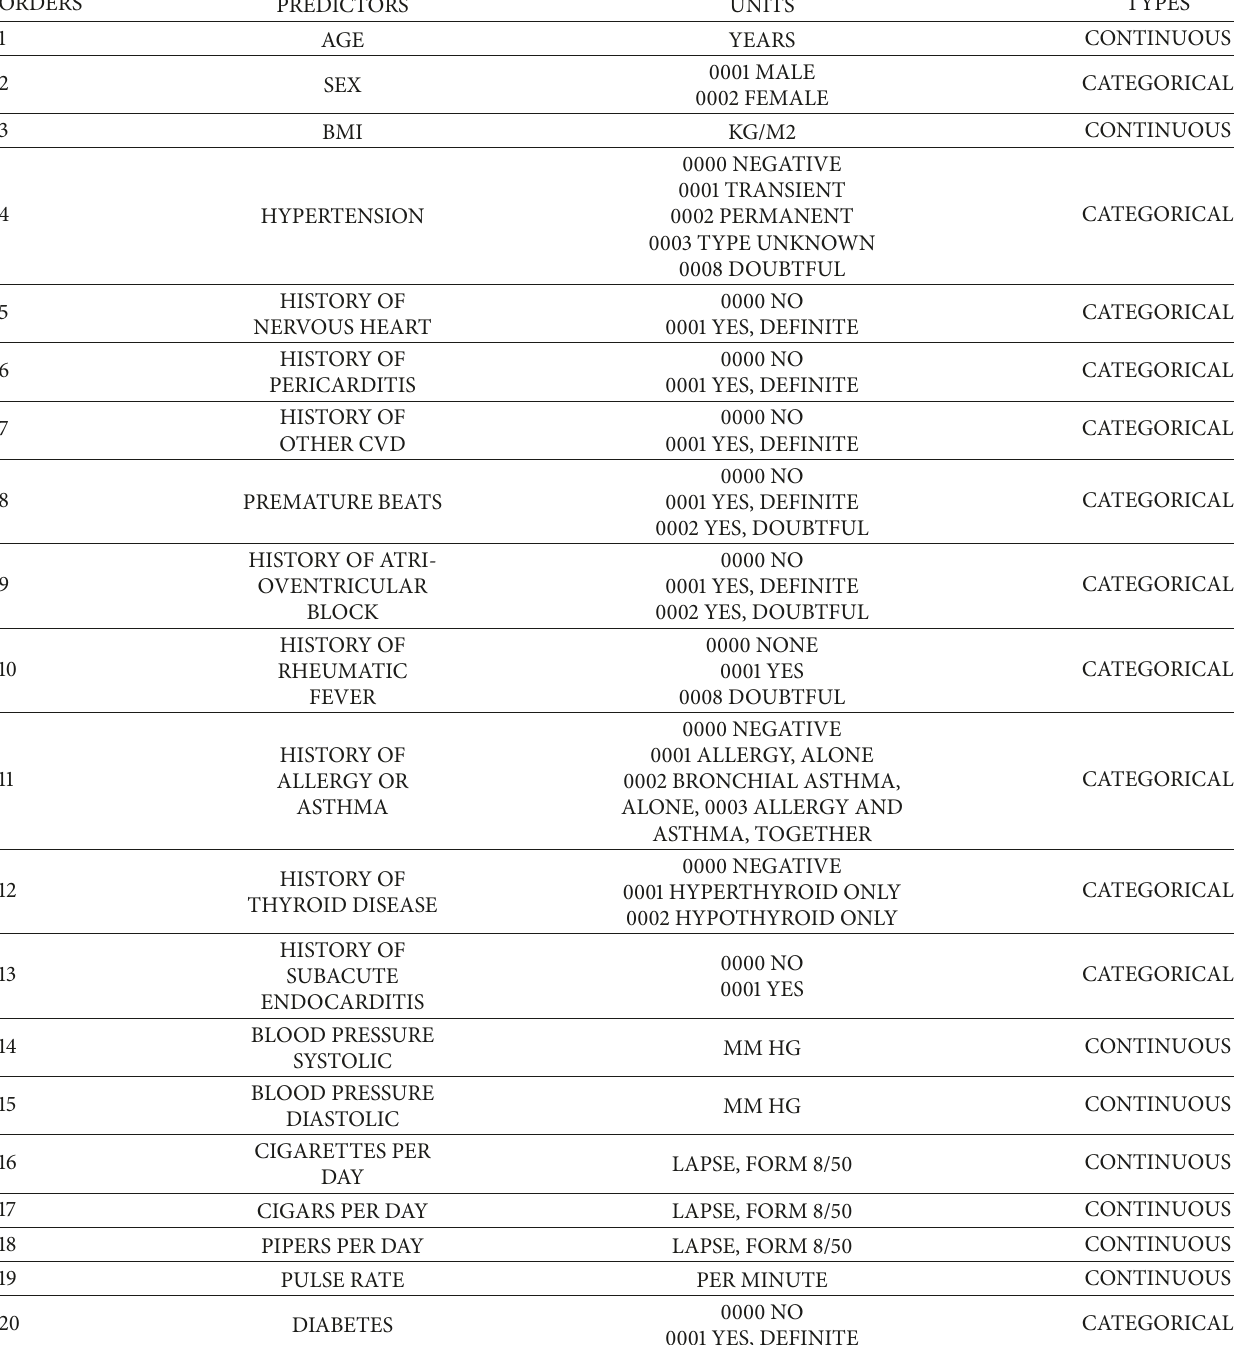
Table 2: Description of candidate